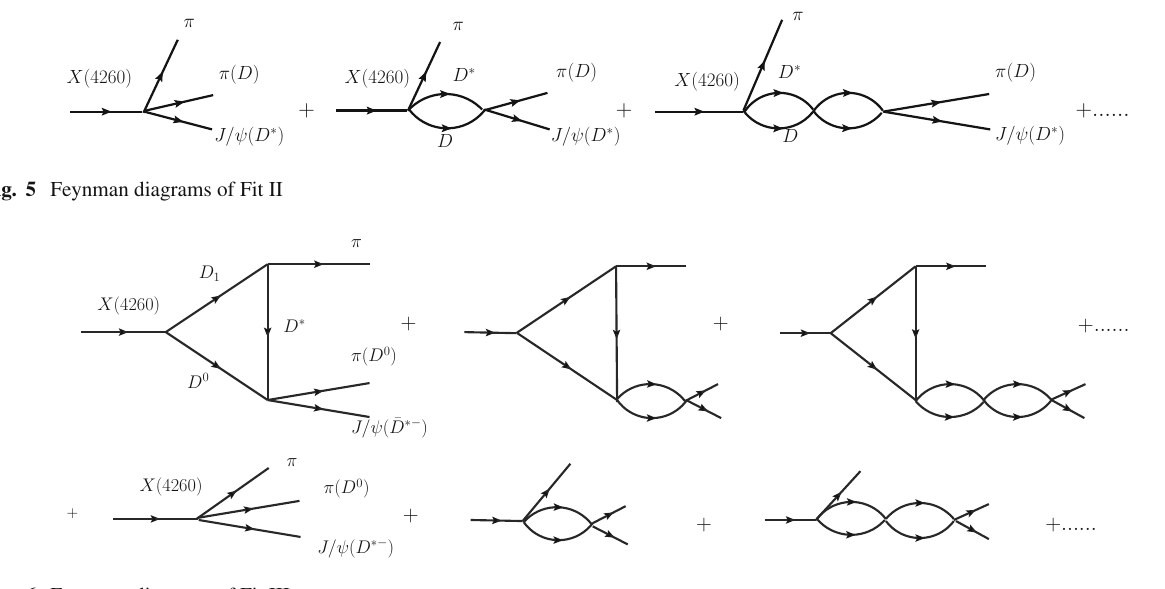
Fig. 6 Feynman diagrams of Fit